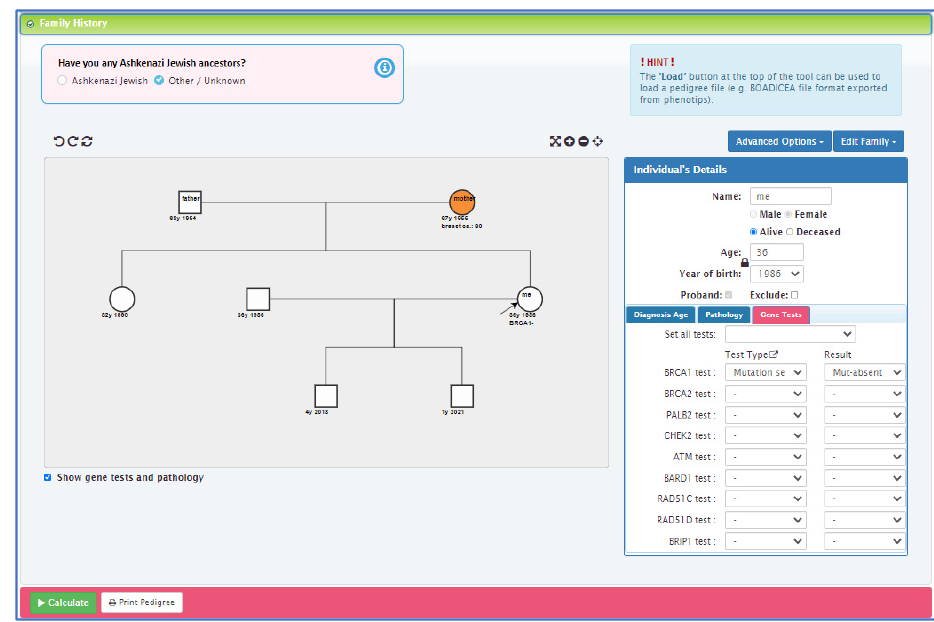
Figure 3. CanRisk tool, detailed view of the interactive graphical pedigree editor.